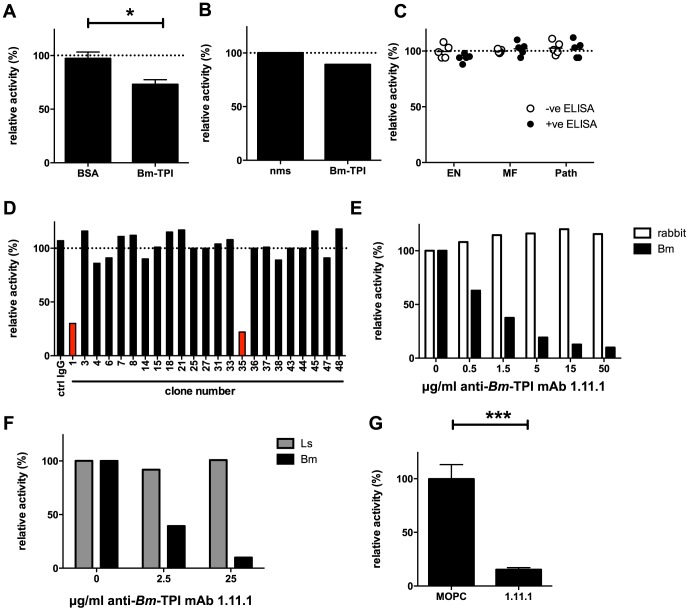
Generation of neutralizing antibodies to Bm-TPI.
A. TPI enzyme activity in presence of 10% serum from jirds infected for 21 weeks with B. malayi following immunisation with BSA or Bm-TPI. * p<0.05 by t-test. B. TPI enzyme activity in presence of 10% polyclonal anti-Bm-TPI serum from BALB/c mice or naive mouse serum (nms). C. TPI enzyme activity in presence of 10% serum from human filariasis patients. Serum was used from the 5 strongest anti-Bm-TPI reactors (black circles) or 5 non-reactors (white circles) from each group (Fig. 3). D. Generation of antibody specificities that neutralise Bm-TPI activity is a relatively rare event. Ability of a panel of murine mAb specific for Bm-TPI (data not shown) to inhibit enzyme activity was determined. Clones with neutralising capacity are shown in red. E. Specificity of neutralizing mAb 1.11.1 for Bm-TPI (black bars) and not rabbit TPI (white bars). F. Specificity of neutralizing mAb 1.11.1 for Bm-TPI (black bars) and not Ls-TPI (grey bars). A, B, E and F are representative of multiple batches of recombinant enzyme. G. Neutralisation of native Bm-TPI activity in BES (4 independent batches) by mAb 1.11.1. MOPC31C IgG1 myeloma protein was used as a control. Dotted lines in (A–D) represent enzyme activity in the absence of serum or antibody (normalised to 100%).*** p<0.001 by t-test.